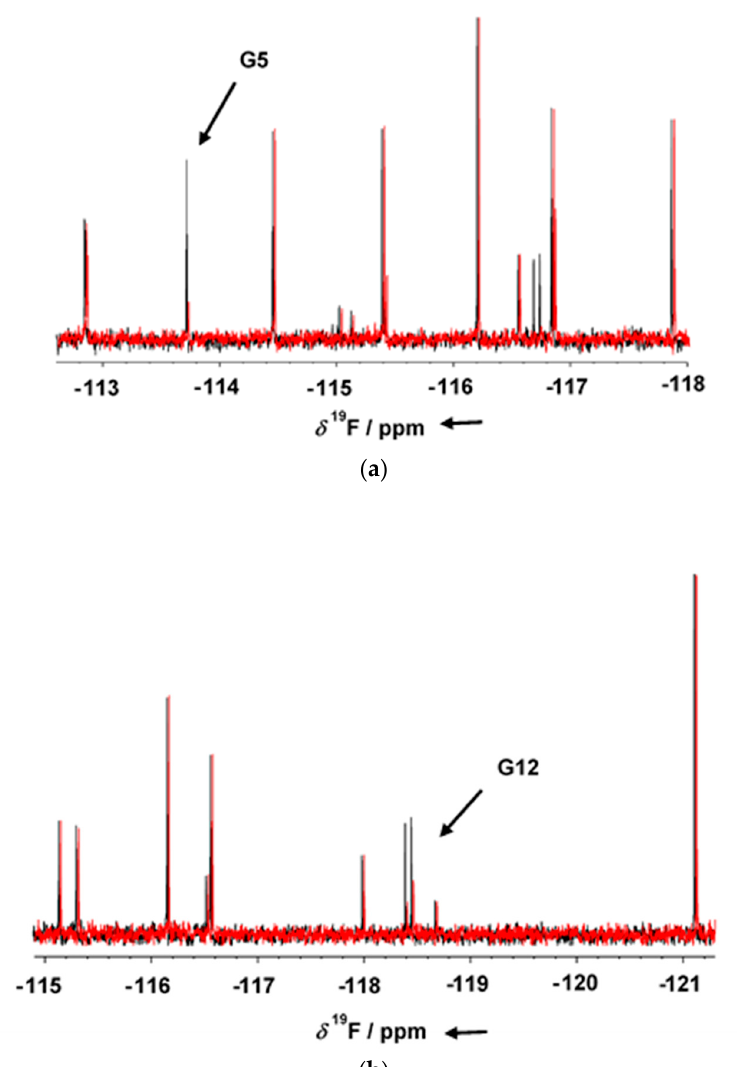
Figure 1. 1D 19 F T 2 filter NMR spectra of fragment mixtures containing G5 ( a ) and G12 ( b ) fragments, in the presence of 1 mM AMP-PNP and in the absence (black) or presence (red) of GSK-3 β . Binding compounds G5 and G12 give clear changes in their resonance signal in presence of protein (arrow). The 19 F T 2 filter spectrum of the two compounds was not affected by the presence of either 1 mM AMP-PNP.